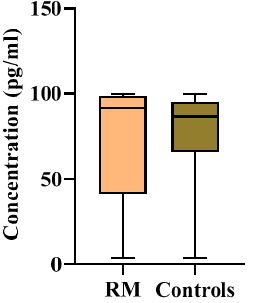
Figure 6. Box and Whisker plot showing serum IL17A concentration (case vs. control). Figure 7. ROC curve of IL17A. Area (CI 95%); p -value = 0.5843 (0.5020–0.6667); 0.0424. The curve illustrates the diagnostic potential of IL17A for this disease.